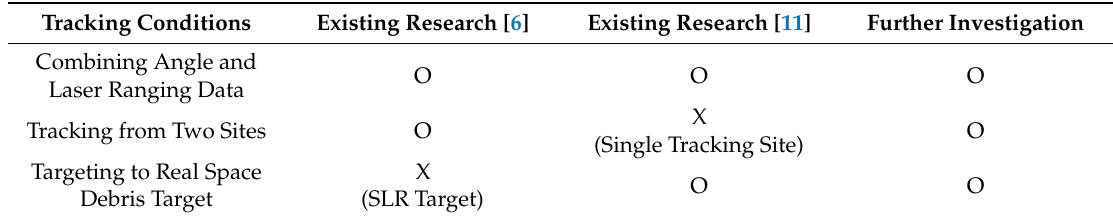
Table 1. The tracking conditions for